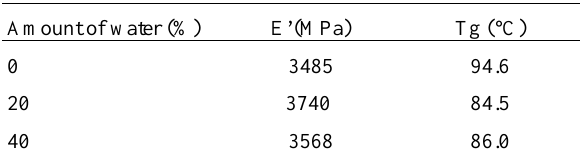
Table 2. Storage modulus (E’) and glass transition temperature (Tg) of polyHEMA with different amount of water used during the synthesis, measured by dynamic mechanical